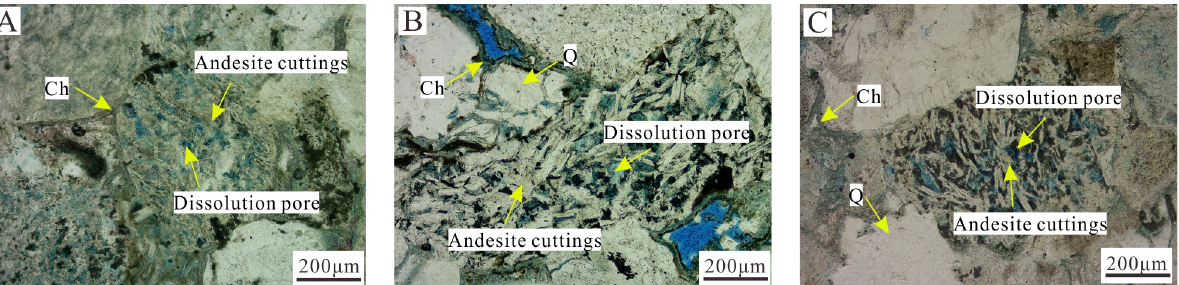
Figure 9. Pore-lining chlorite and andesite rock fragments internally dissolved pores. ( A ) Well Bei 210, 3949.97 m, plane-polarized light. ( B ) Well Bei 202, 3112.75 m, plane-polarized light. ( C ) Well Bei 210, 3949.5 m, plane-polarized light. Ch—Chlorite; Q—Quar tz .